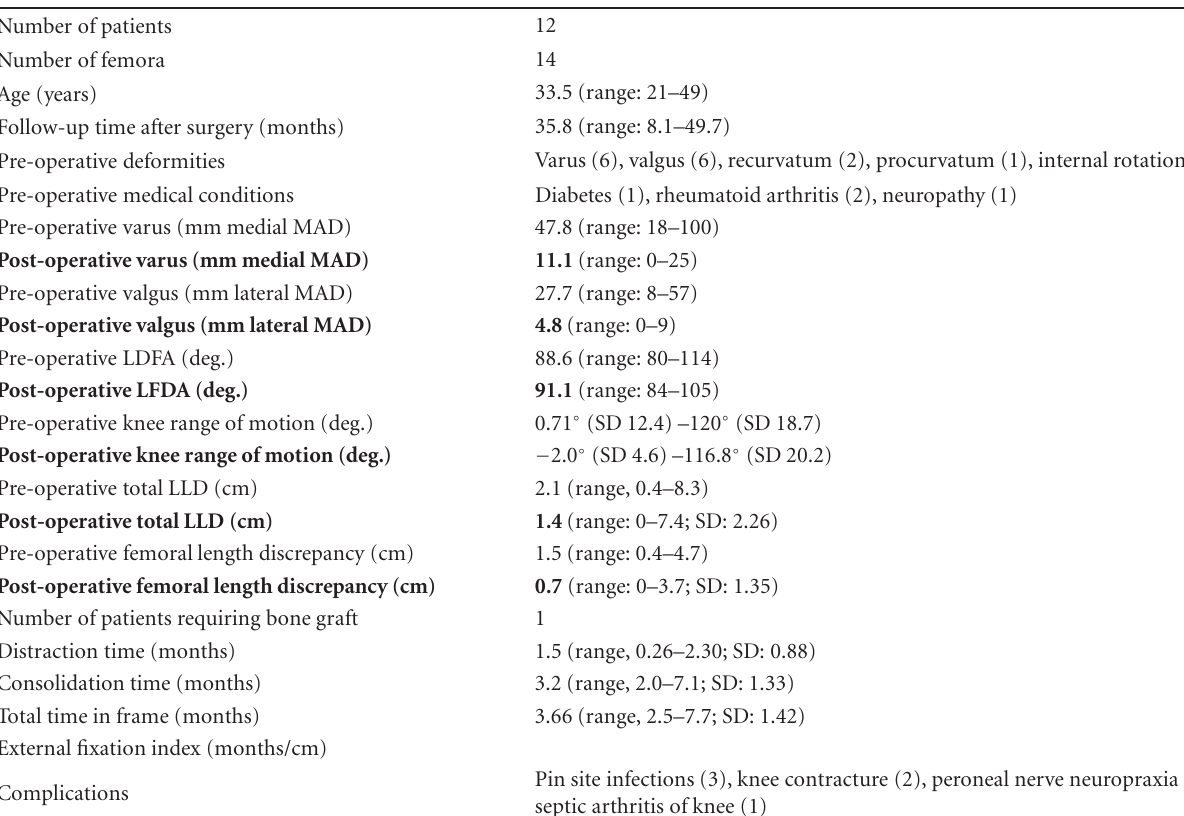
Table 3: Femoral deformity correction